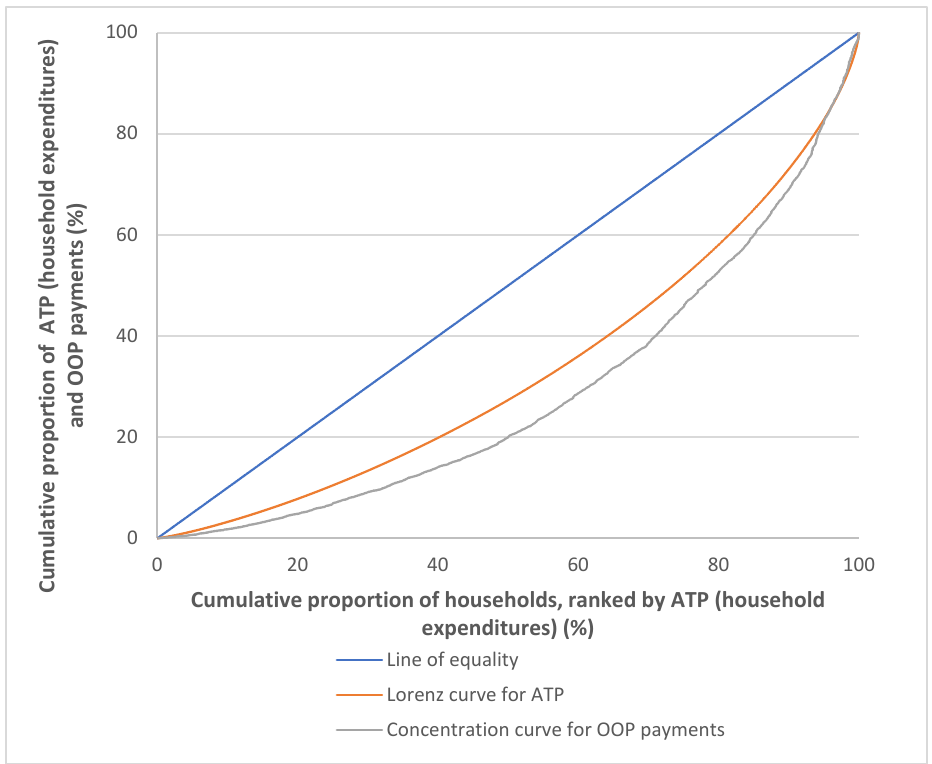
Figure 3. Concentration curves for OOP healthcare payments, Malaysia 2014/2015. Cumulative population shares of household expenditures and OOP healthcare payments increased along the household ATP quintiles. The richest 20% quintile (Q5) had almost half of the total household expenditure shares (42.06%), while the poorest 20% quintile (Q1) (7.72%) had less than 10% of household expenditure shares (Table 2). A similar pattern observed in shares of OOP healthcare payments, in which Q5 had the largest shares at 46.98%, as compared to Q1, which had only 4.91%. Both household expenditures and OOP healthcare payments were more concentrated among the richer households, as is evident from a positive value of the concentration index for OOP healthcare payments (0.4296). From the Gini coefficient and concentration index, it came up with a positive KPI value of 0.0910, which indicates a progressive OOP payment for healthcare in Malaysia (Table